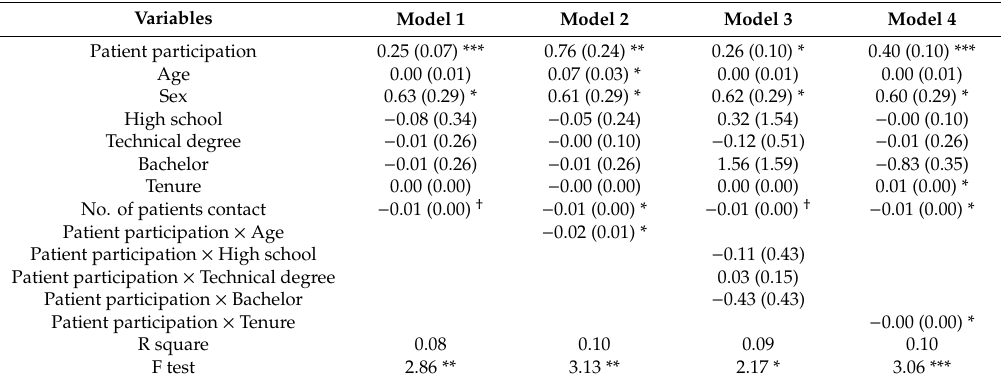
Table 5. Interaction between patient participation and nurse sociodemographic on job satisfaction.